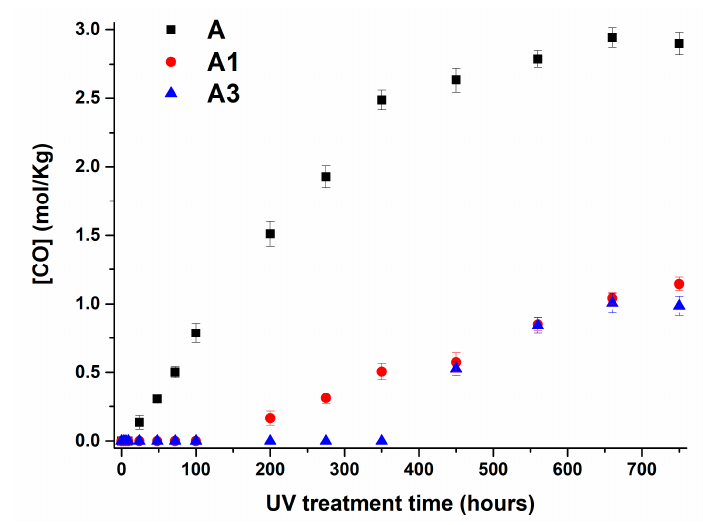
Figure 15. Carbonyl concentration vs. UV irradiation time for A, A1 and A3 samples. Materials 2017 , 10 , 943